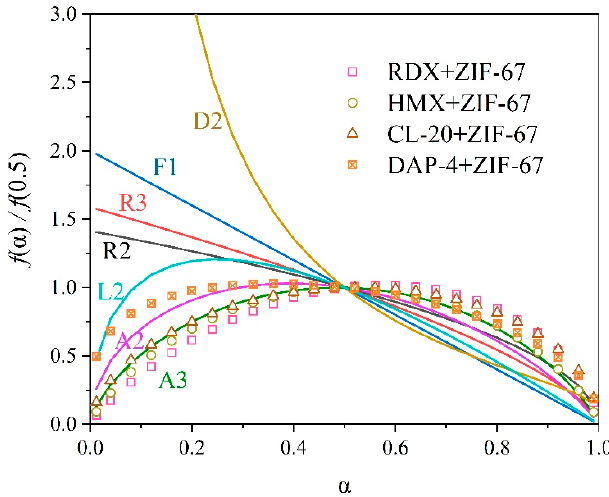
Figure 12. Dynamic model